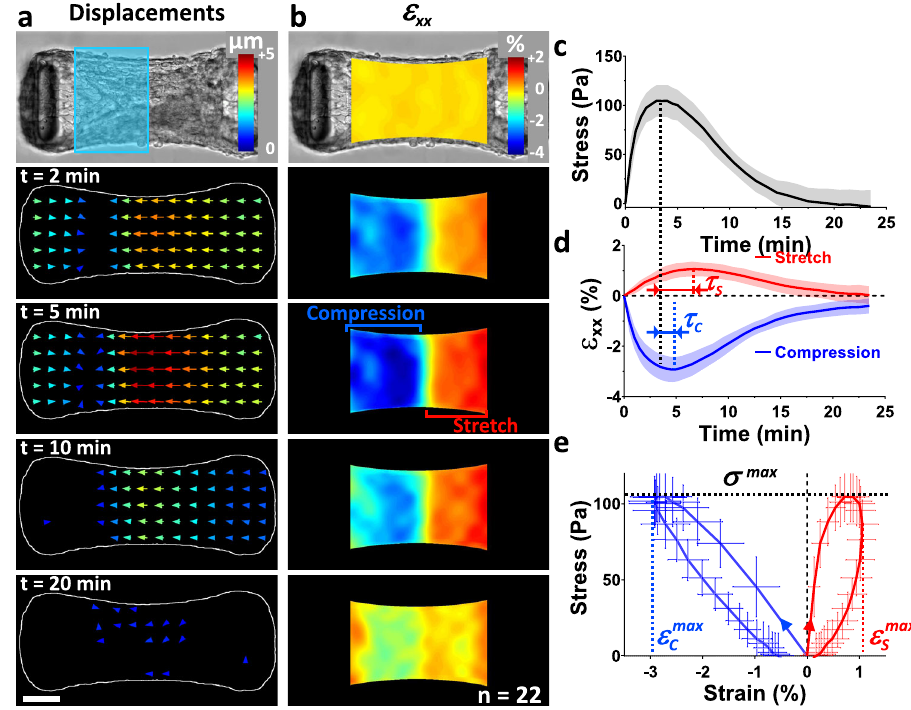
Fig.3|Light-inducedlocalcontractionsevidencetheviscoelasticpropertiesof microtissues. Temporal evolution of the average displacement ( a ) and ε xx strain fi eld( b )afterstimulationofthelefthalfofthetissuebybluelight(symbolizedbya bluerectanglein a ). c Evolutionofthestress σ xx overtimeand d resultingstrain ε xx decomposed in its positive (stretch, in red) and negative (compression, in blue)